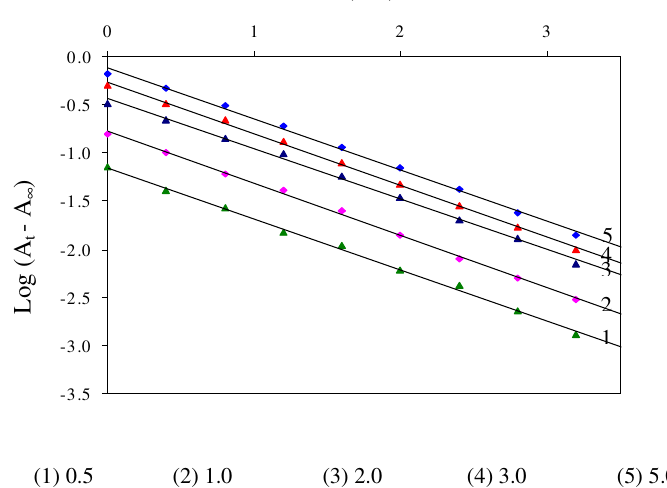
Figure 1. First order plots of aqueous alkaline permanganate oxidation of L-Proline at 25 o C. [MnO 4- ] x 10 4 (mol dm -3 );